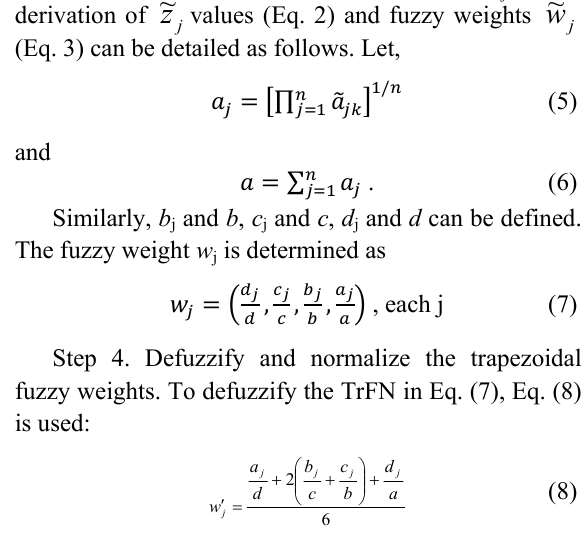
Table 2. Fuzzy evaluation scores for